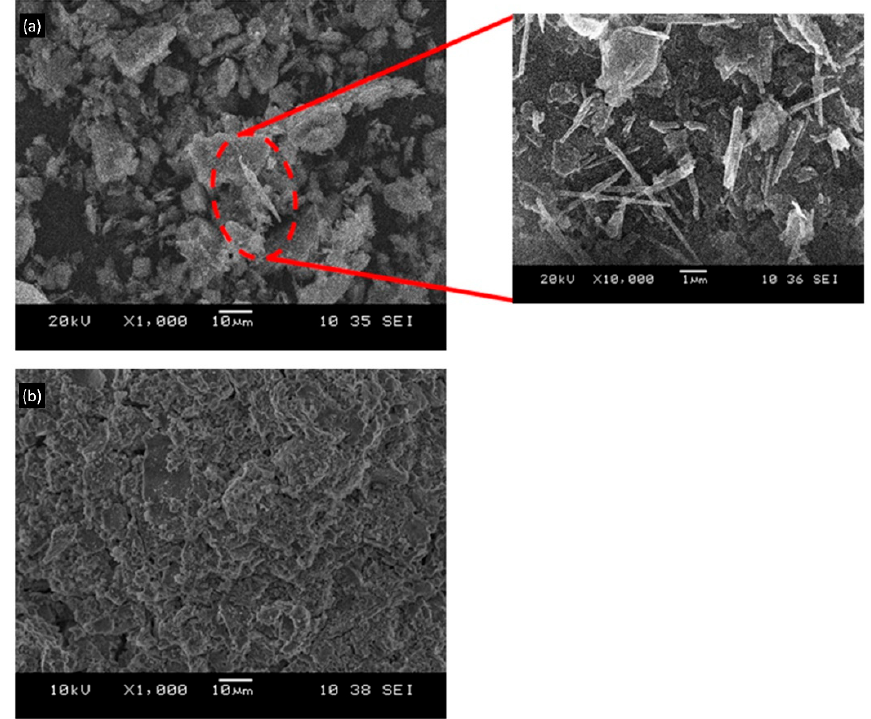
Figure 2. SEM micrograph of ( a ) raw kaolin and ( b ) kaolin-based geopolymer.